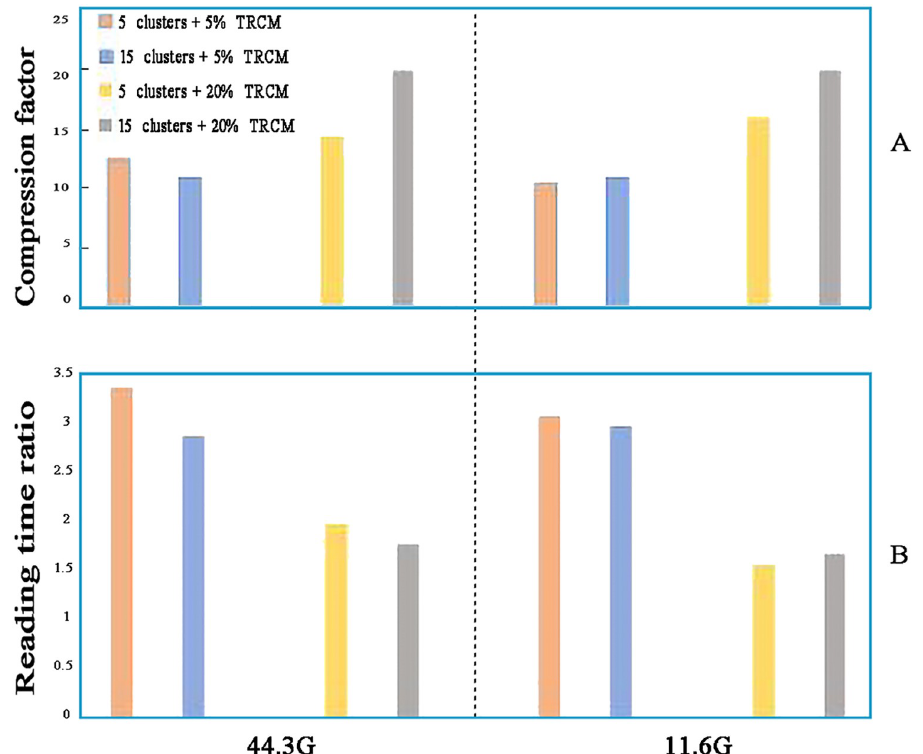
Fig 5. Factors that influence the performance of